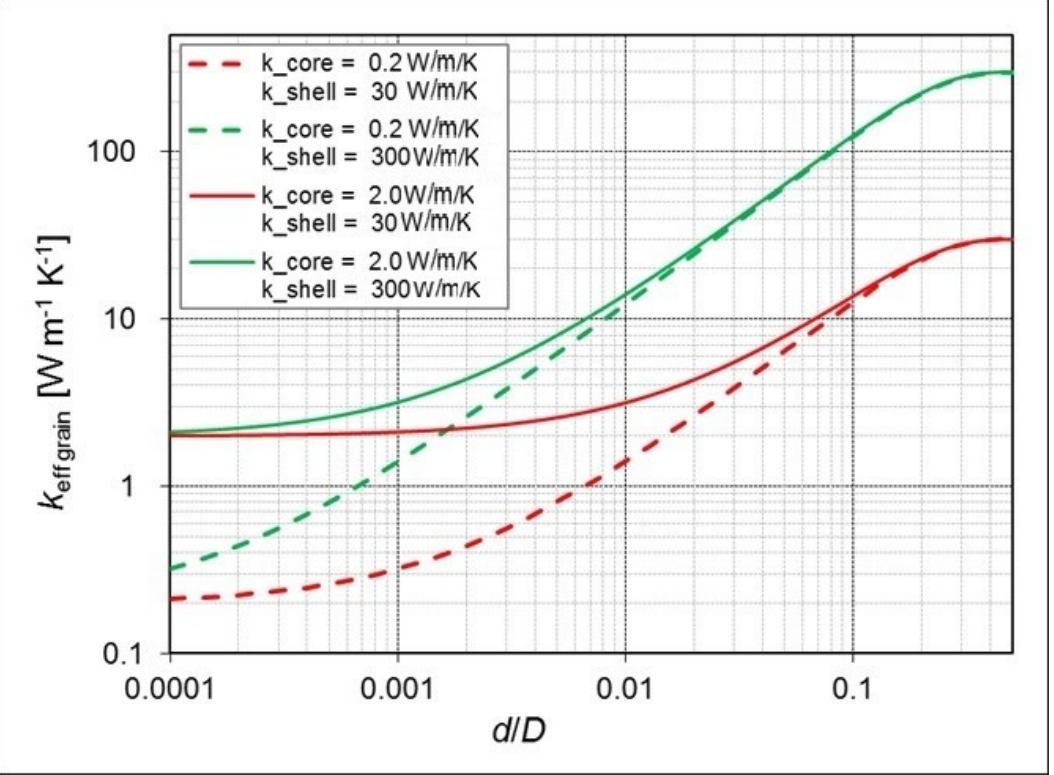
Figure 2. Effective thermal conductivity of a core-shell filler according to Equation (4), plotted versus the ratio of the thickness of the shell 𝑑 to the total grain diameter 𝐷 , for the core thermal conductivities 𝑘 (cid:2913)(cid:2925)(cid:2928)(cid:2915) of 0.2 and 2.0 W m –1 K –1 and the shell conductivities 𝑘 (cid:2929)(cid:2918)(cid:2915)(cid:2922)(cid:2922) of 30 and 300 W m − 1 K − 1 .